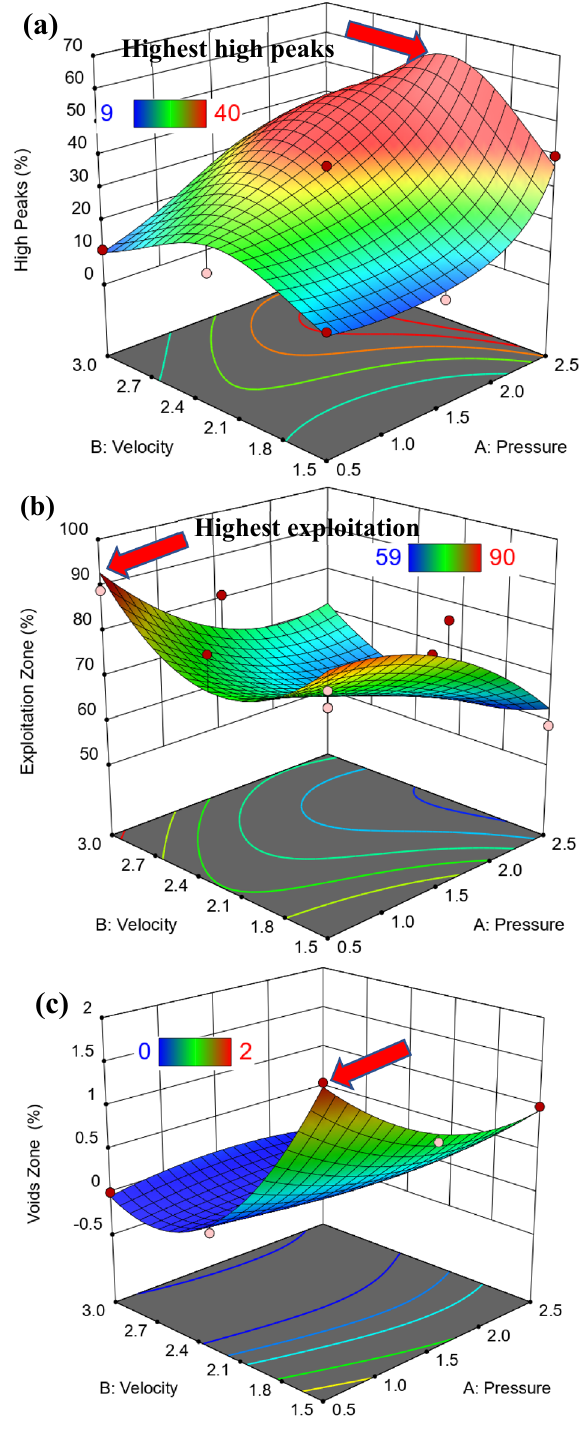
Figure 14. 3D Surface plot of ( a ) high peaks, ( b ) exploitation, and ( c ) voids of QAM f